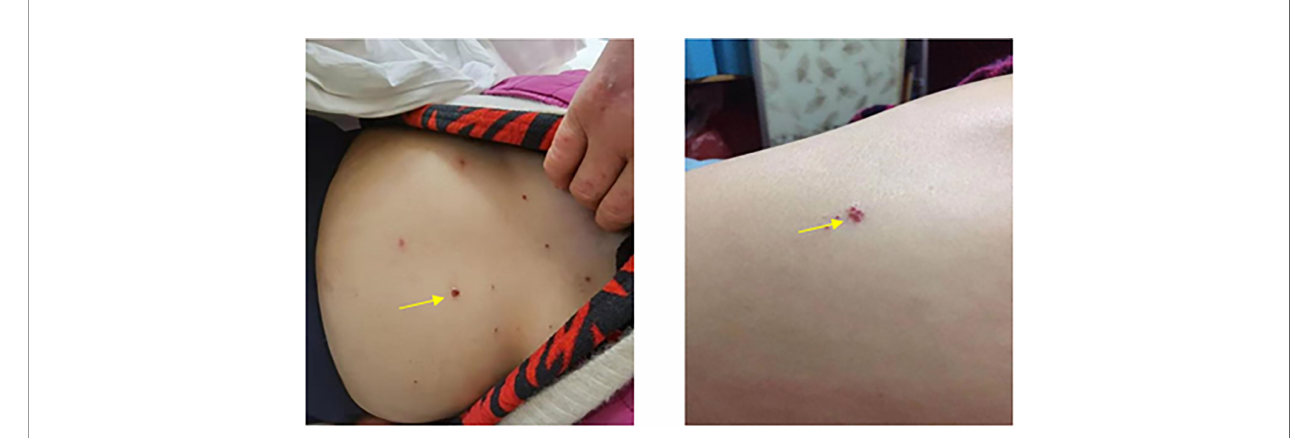
FIGURE 3 | Reactive cutaneous capillary endothelial proliferation (RCCEP) ( yellow arrows )